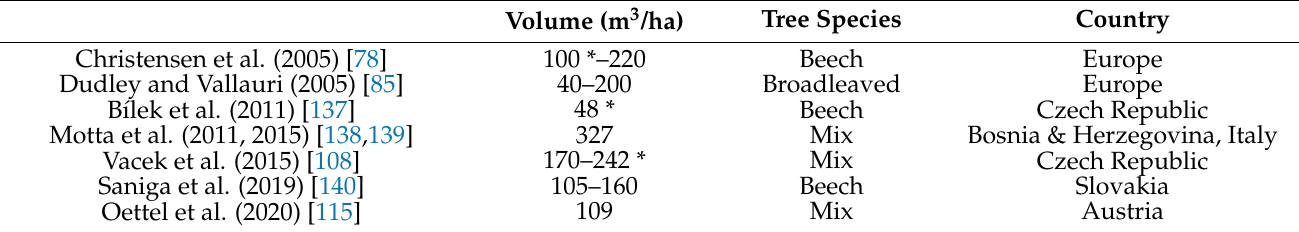
Figure 3. Stages of enrichment: ( 0 ) A stand with no deadwood. ( a ) The first leaving of the wood to disintegrate. ( b ) A medium-intensity decomposition degree at about 2/3 of the time period of the enrichment. ( c ) A barely visible, highly decomposed log and the following phase of the purposeful leaving of the deadwood in the site. The arrow above the picture indicates the decomposition process, the lighter the shade, the more decomposed the wood. Table 2. Volume of deadwood in the forest reserve.